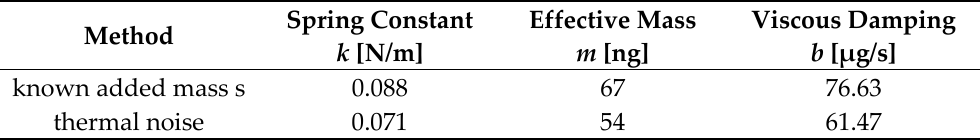
Table 2. PF cantilever mechanical impedance